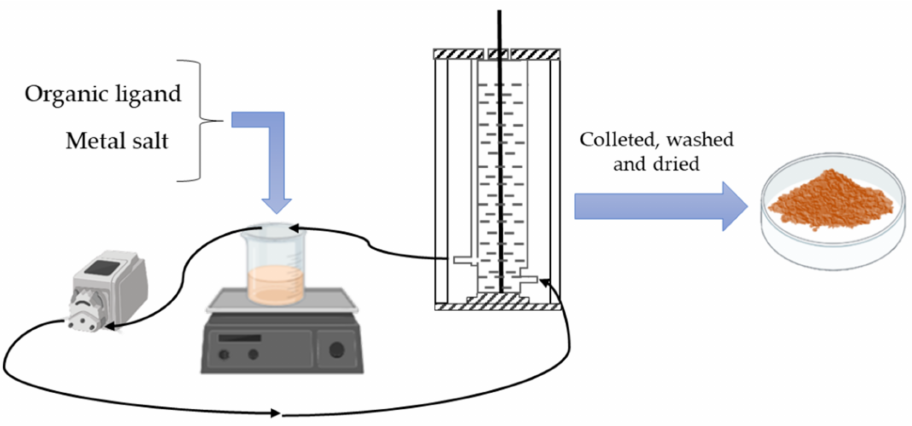
Figure 5. Schematic of the procedure found in papers using this synthesis